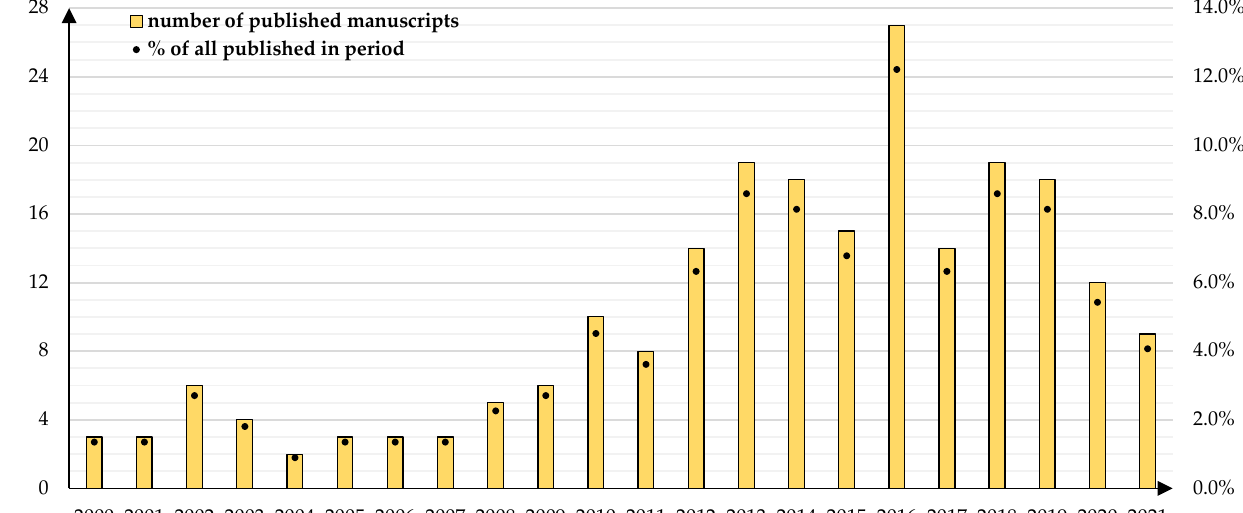
Figure 2. Number of published manuscripts in each year and the corresponding percentage.